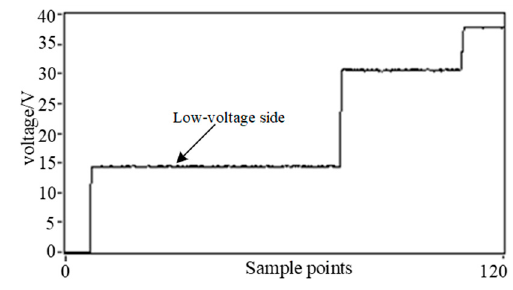
Figure 21. Low-voltage terminal voltage.